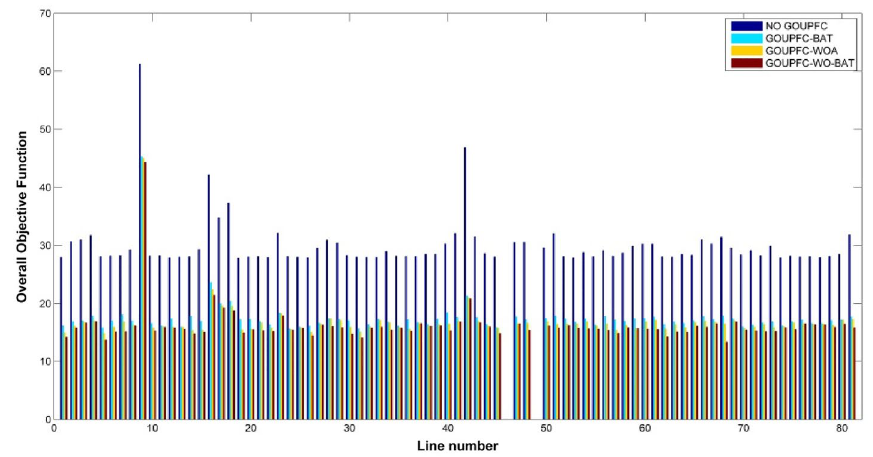
Fig. 9 GOUPFC performance under single contingency and 50% RES